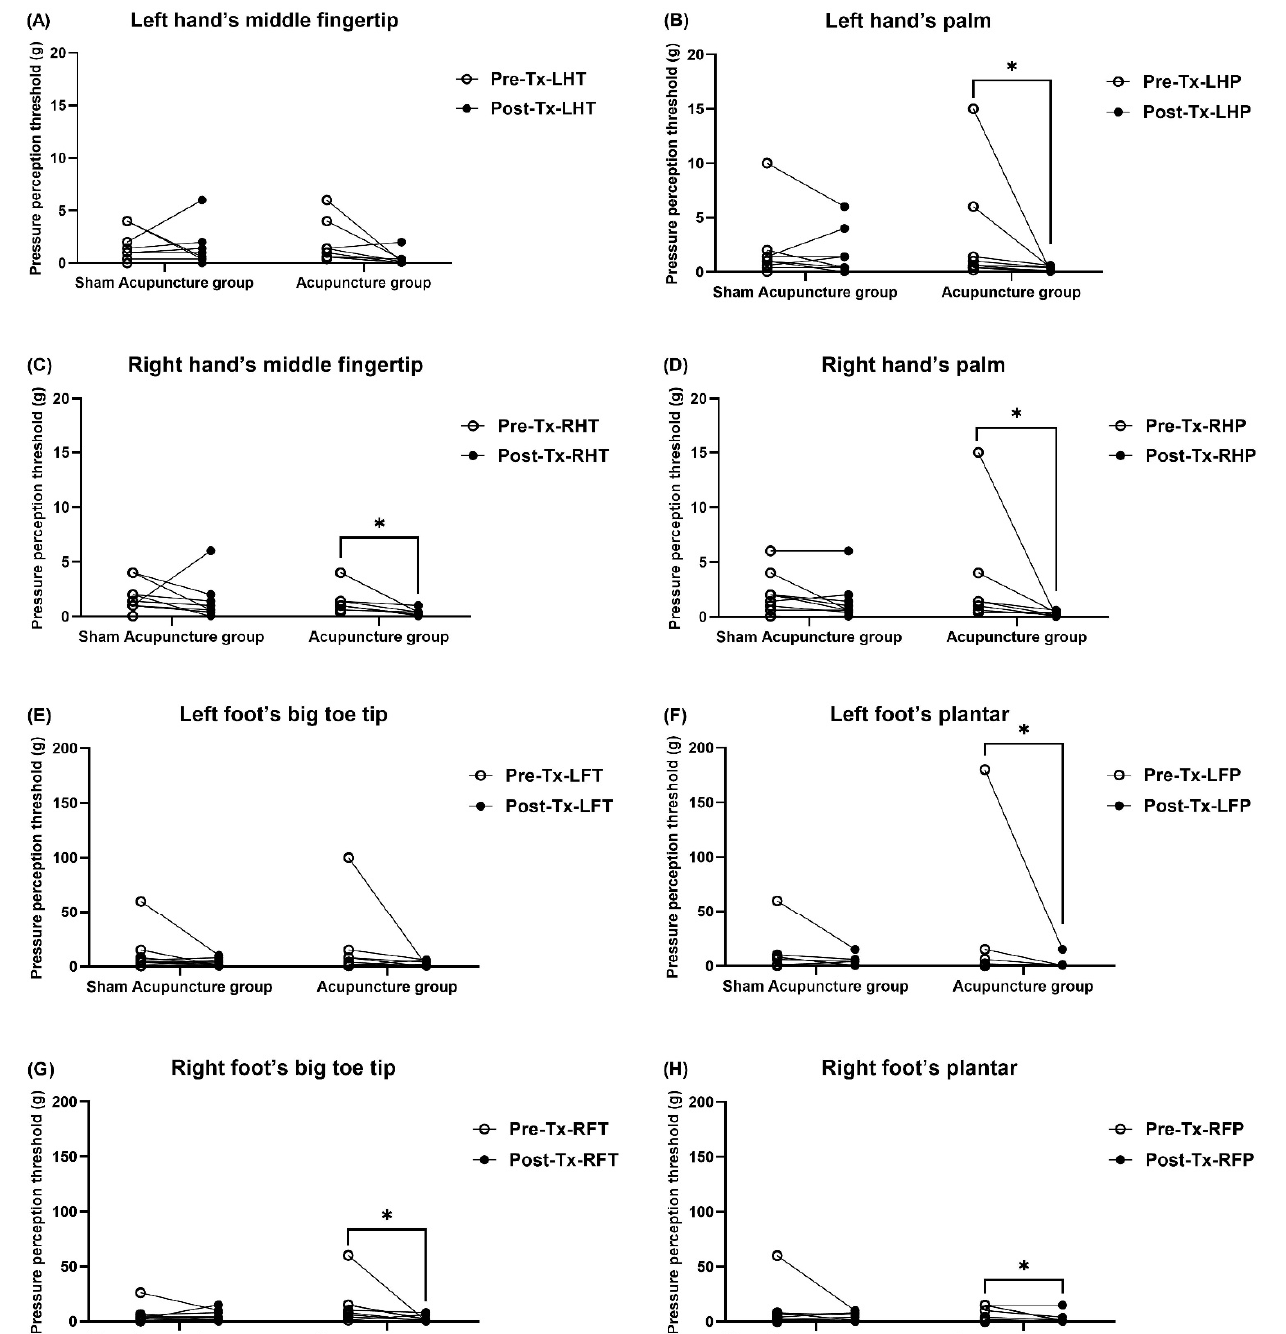
Figure 3. ( A – H ) Mechanical touch-pressure detection thresholds at the fingers, palms, toes, and plantars using Semmes– Weinstein monofilament evaluation measured before and at the 9th week after 15 treatment sessions. * p < 0.05 represents the within-group values validated using the Wilcoxon signed-rank test. Abbreviations: LHT, Left hand’s middle fingertip; LHP, Left hand’s palm; RHT, Right hand’s middle fingertip; RHP, Right hand’s palm; LFT, Left foot’s big toe tip; LFP, Left foot’s plantar; RFT, Right foot’s big toe tip; RFP, Right foot’s plantar.